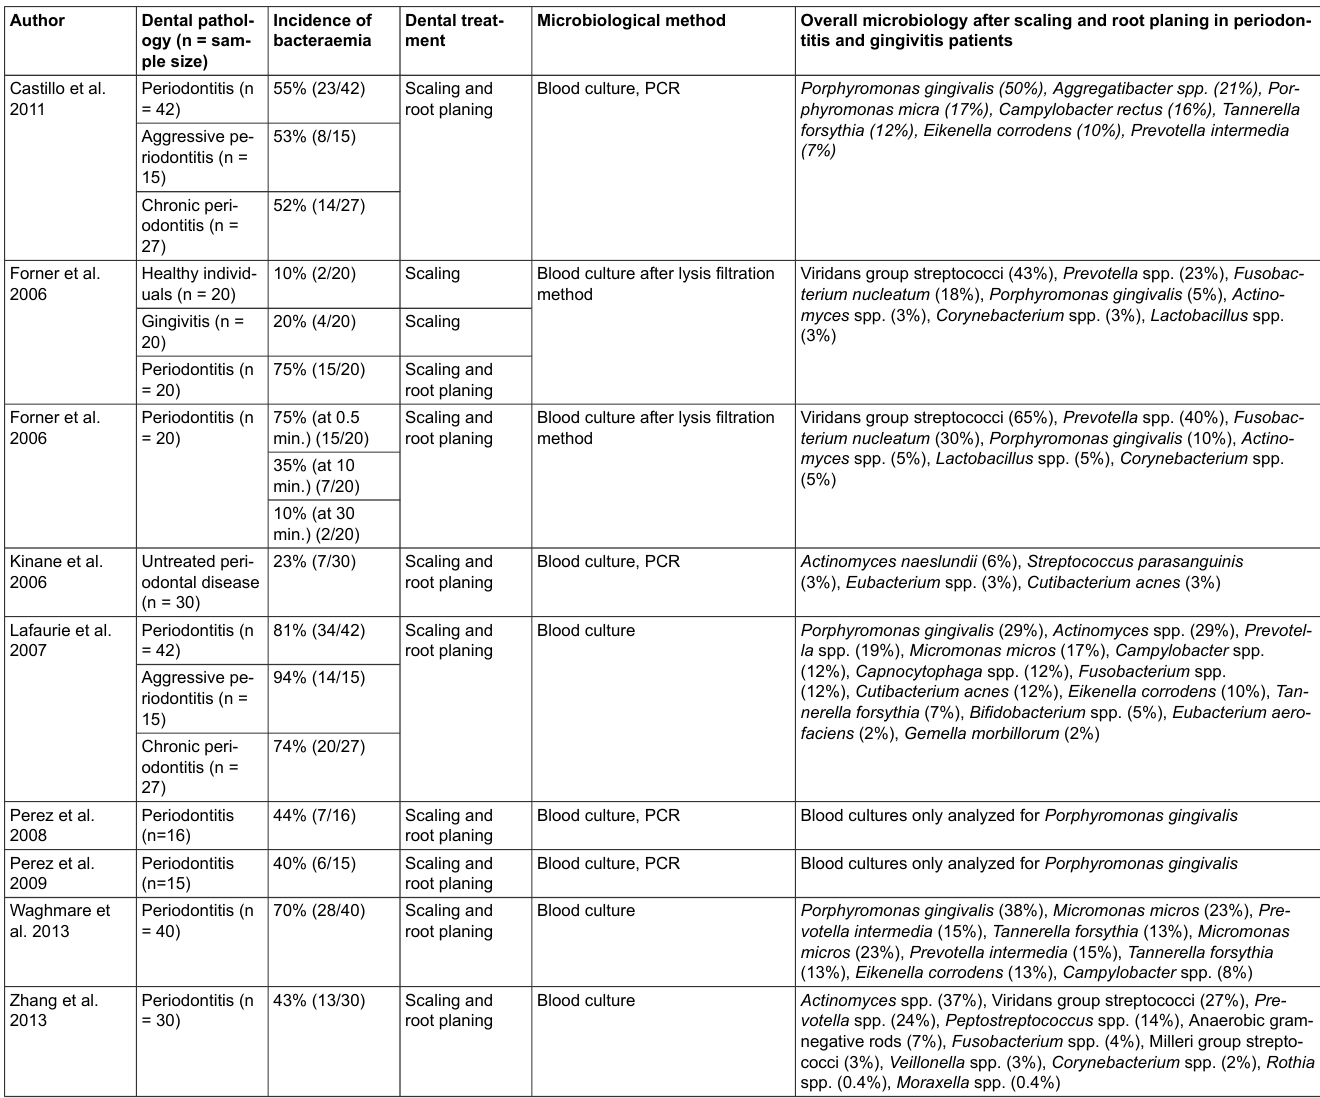
Table 1: Frequency and microbiology of bacteraemia after periodontal